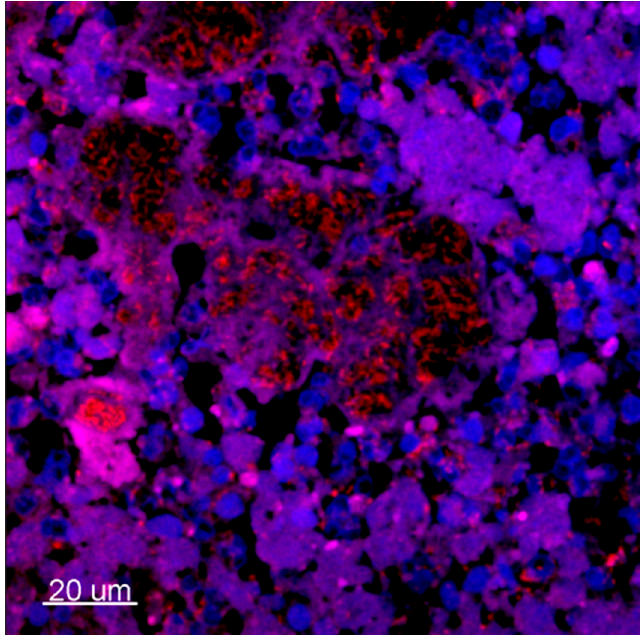
Figure 1. Confocal laser-scanning microscopy micrography of ex vivo lung tissue from a P. aeruginosa -infected CF patient. Tissue was stained with peptide nucleic acid fluorescence in situ hybridization (PNA-FISH) probes specific for P. aeruginosa with a red Texas-Red flourophor and counterstained with blue (4 ′ ,6-diamidino-2-phenylindole) DAPI for eukaryotic nucleus. 630×. [19].